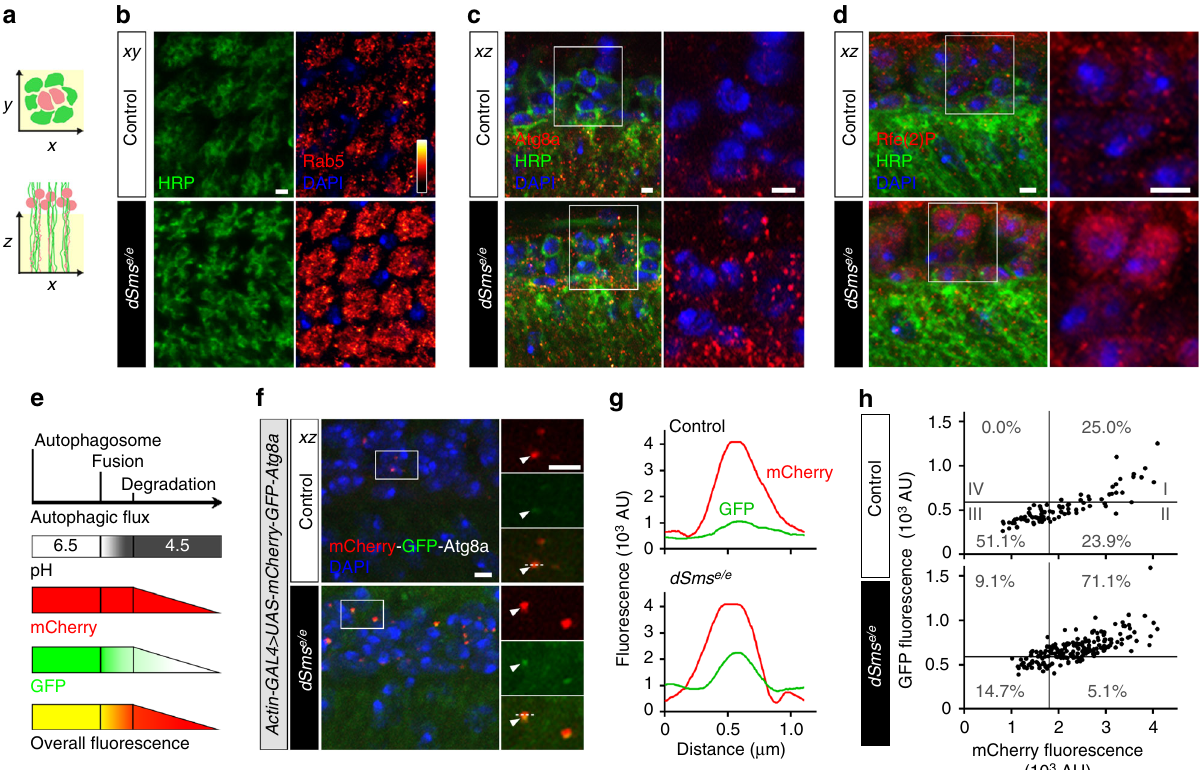
Fig. 3 Loss of dSms impairs autophagy fl ux in dSms mutant synapses. a Cross sections of lamina synapses on the xy -plane and xz -plane are drawn for reference. b Confocal micrographs of immunostaining for early endosomes using marker Rab5 (intensity indicated with heat map). Neuronal membranes labeled with HRP and nuclei counterstained with DAPI. c Confocal micrographs of Atg8a immunostaining of endogenous phagophore/autophagosomes on 2 DAE fl y laminae. Boxed area (left) indicates high magni fi cation (right) of lamina neuronal cell bodies. d Confocal micrographs of Ref(2)P immunostaining of 2 DAE fl y laminae. Boxed area (left) indicates high magni fi cation (right) of lamina neuronal cell bodies. e Diagram showing the reporting mechanism of mCherry-GFP-Atg8a fusion protein. The pH of the autophagosome decreases from 6.5 to 4.5 upon fusion with the lysosome. GFP fl uorescence is quenched in low pH environment, while mCherry fl uorescence remains until the protein is degraded (slope). f Atg8a fl ux determined through overexpression of mCherry-GFP-Atg8a in control and dSms e/e fl ies and visualized by confocal microscopy of lamina. Boxed area (left) indicates high magni fi cation (right) of lamina neuronal cell bodies. Arrowheads indicate representative Atg8a-positive puncta plotted in g and quanti fi ed in h . g Histogram plot of the fl uorescence intensity in arbitrary units (AU) along the dotted lines indicated in high-magni fi cation images in f . h Scatter plot of Atg8-positive puncta measured from control ( n = 4 animal) and dSms e/e ( n = 3 animal) animals (eight sections from each animal). The plot was divided into four quadrants using threshold of GFP = 570, mCherry = 1800 with the percentage of puncta in each quadrant indicated. All scale bars, 2 µ